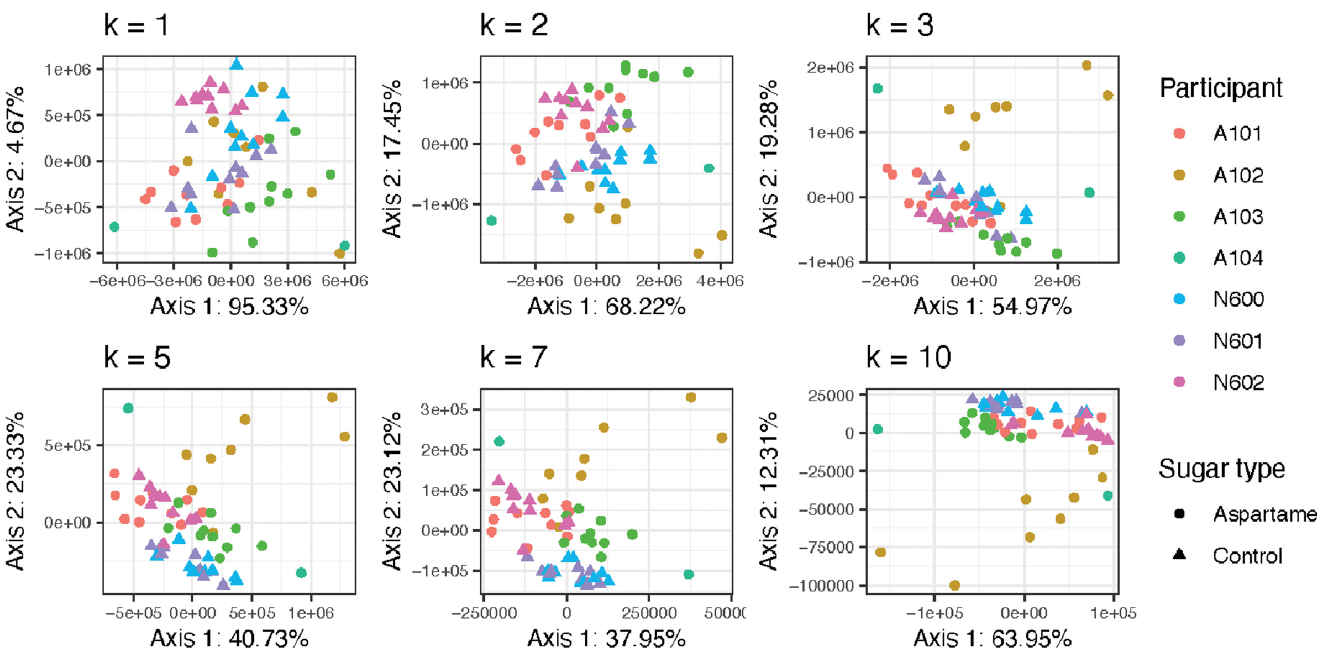
Fig 11. Visualization of the samples in the non-nutritive sweetener study using CMDS and the EKS distance for a range of values of k . For each value of k , the EKS distance was computed for every pair of samples. CMDS was run on the resulting distance matrices, giving an embedding of the samples into Euclidean space. The positions of the samples on the top two CMDS axes are shown for each value of k . Each point represents a sample, color represents the individual from whom the sample was taken, and shape represents the type of sweetener the participant was given (either aspartame or a control for the samples included here.).